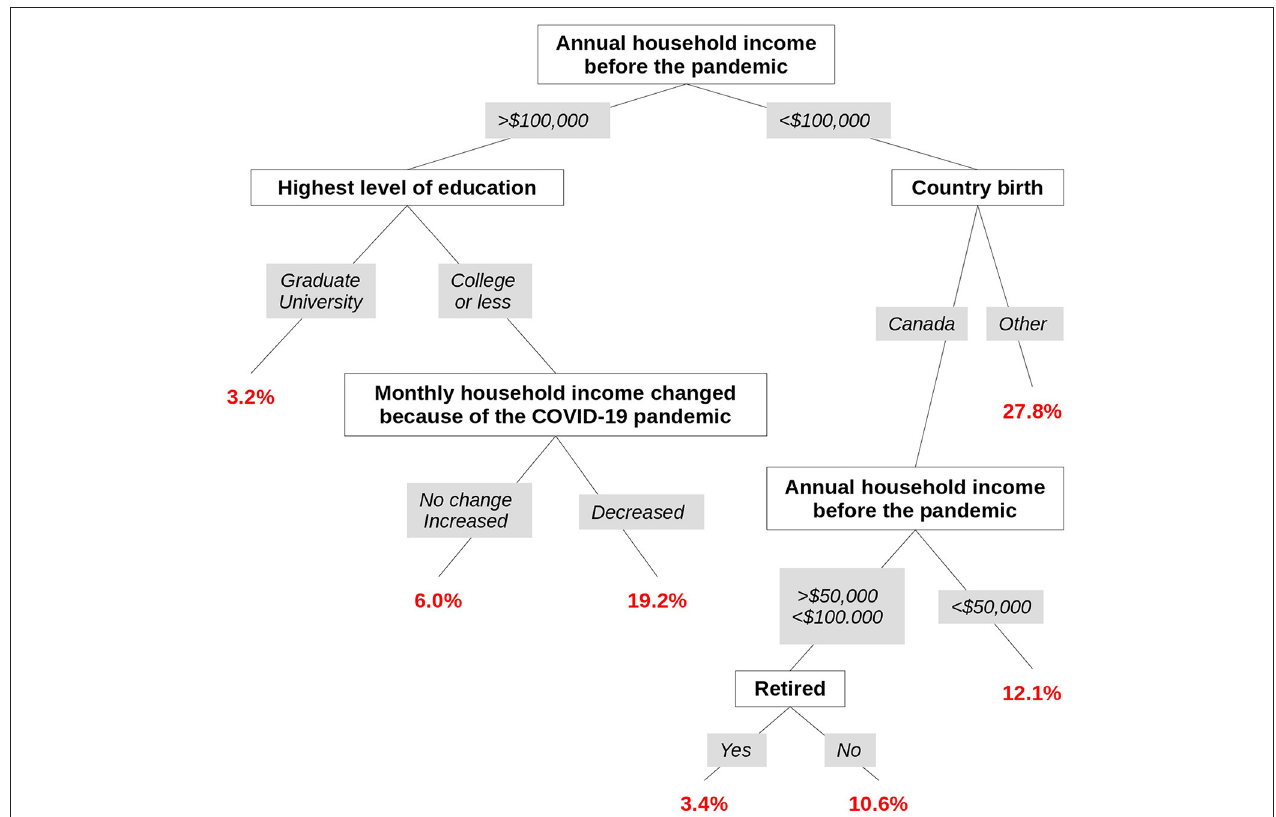
FIGURE 3 | Tree-based multivariate model with adjustment on age for vaccine